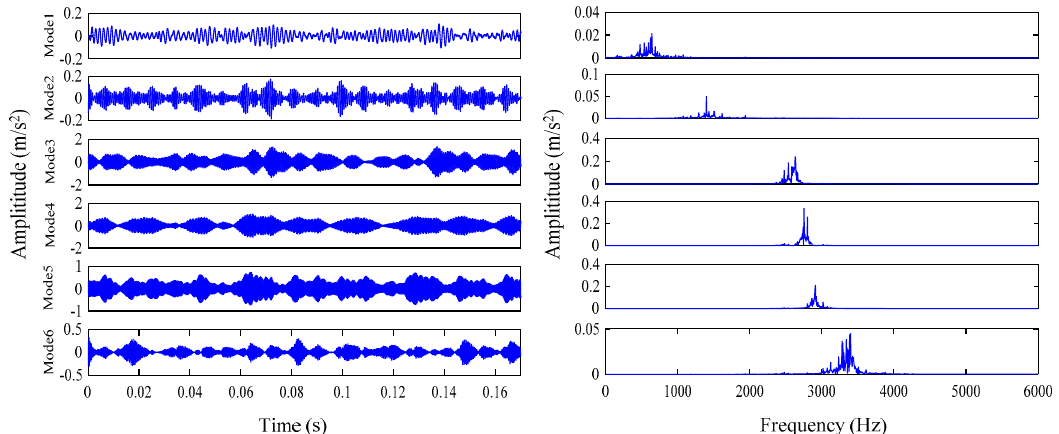
Figure 21. Decomposition results and corresponding frequency spectrum of modes for outer ring defect with VMD.